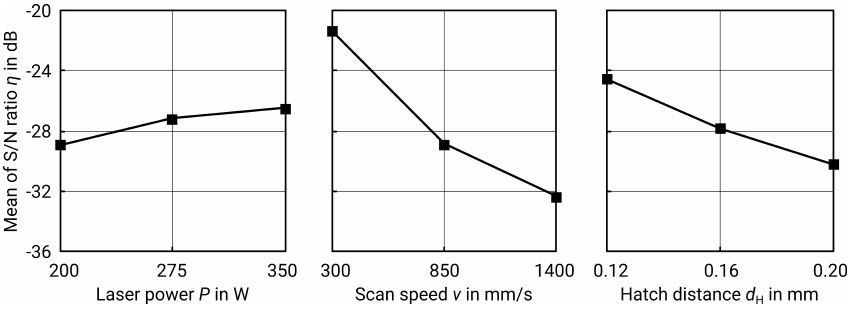
Figure 8. Main effect plot for S/N ratios for S a of upskin surfaces.